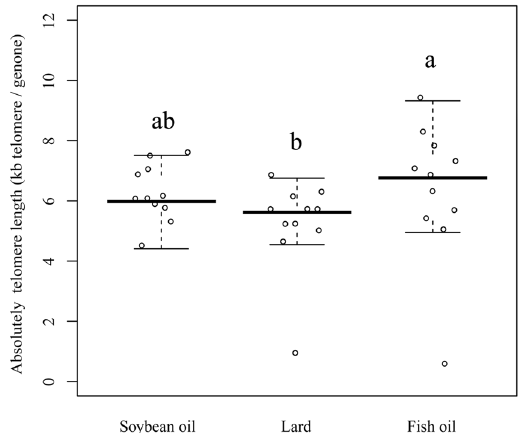
Figure 5. Hepatic absolute telomere length of rats fed soybean oil, lard and fish oil diets. Values are shown as means ± SE (n = 11). Different letters indicate significant difference ( P <